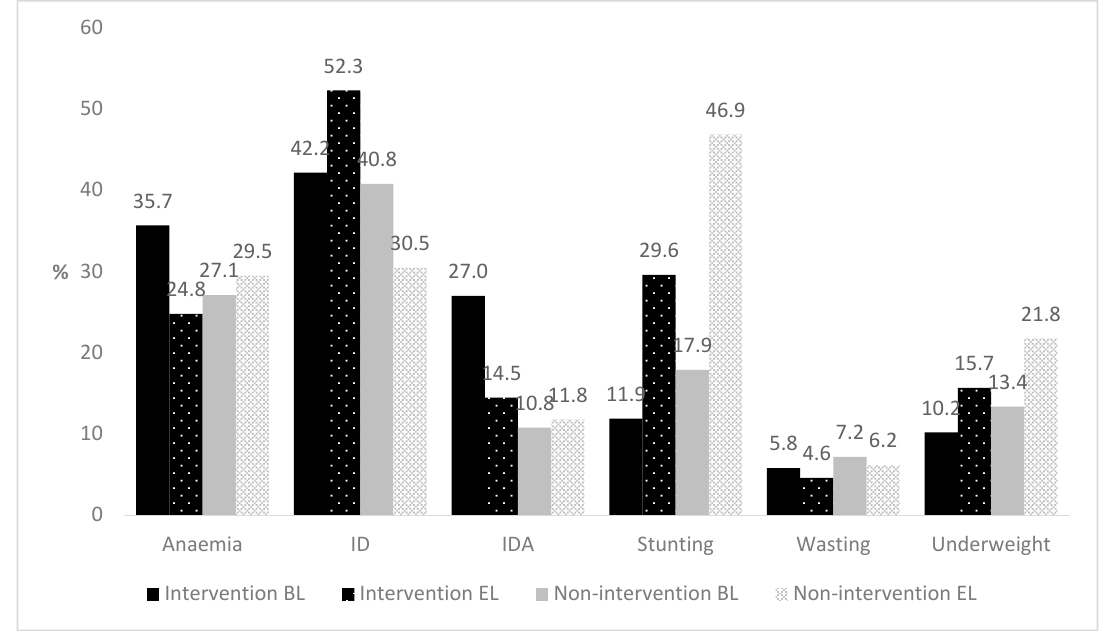
Figure 2. Prevalence of Anaemia, Iron Deficiency (ID), Iron Deficiency Anaemia (IDA), Stunting, Wasting and Underweight at baseline (BL) and end line (EL) in intervention and non-intervention groups. Differences in end line prevalence between intervention and non-intervention groups were tested with Logistic Regression, adjusted for age, gender, and baseline prevalence (and matched pairs for stunting, wasting and underweight).